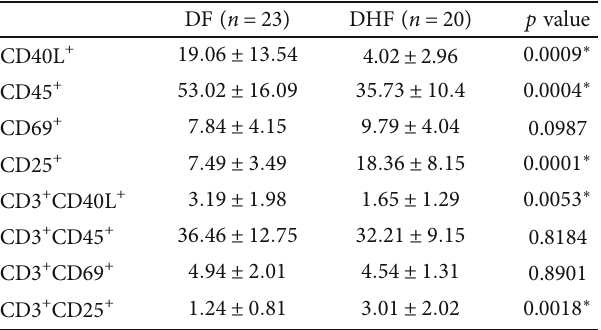
Data are from fl ow cytometry experiments shown in Figure 3; numbers represent percentages. p values were determined by the Mann – Whitney U test; ∗ mean signi fi cance between DF and DHF, p < 0 : 05 .